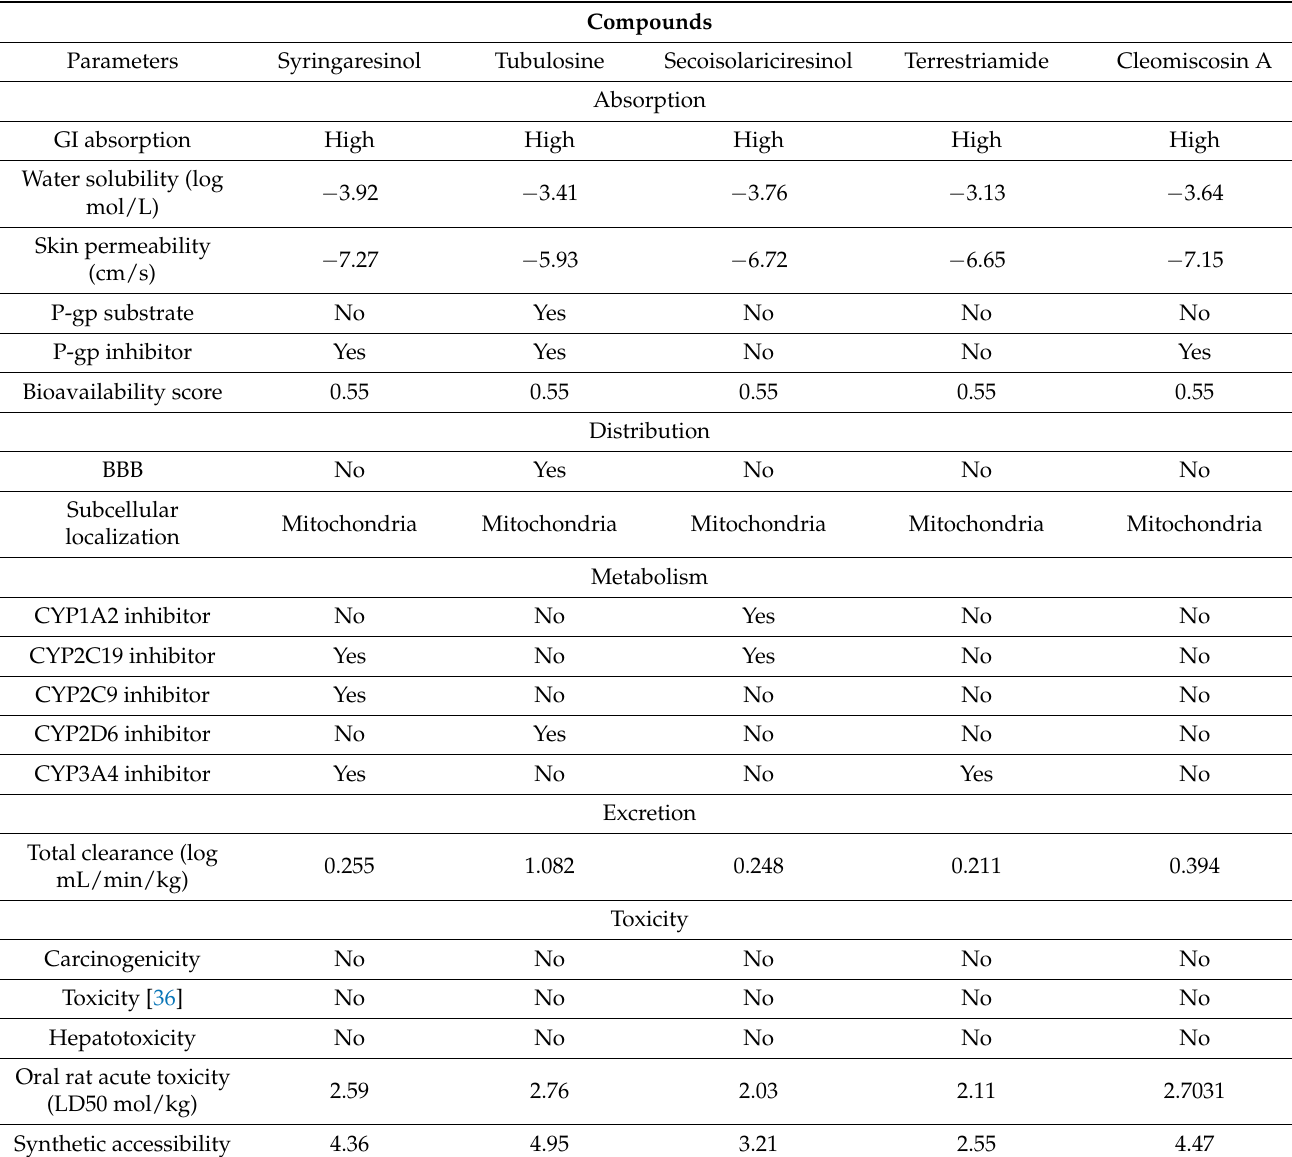
Table 3. ADMET profiles of shortlisted